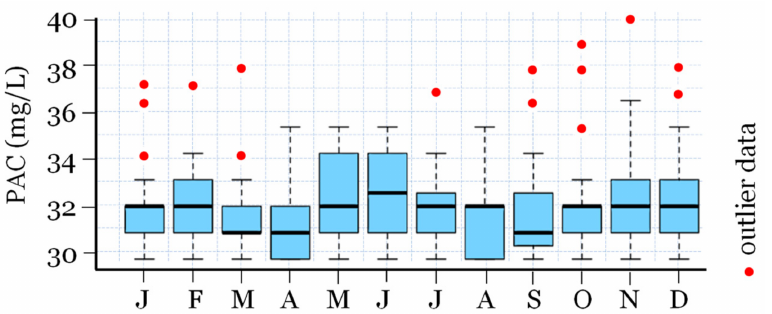
Figure 6. Data behaviors and occurrence of outliers related to coagulant dose throughout the year (January to December).